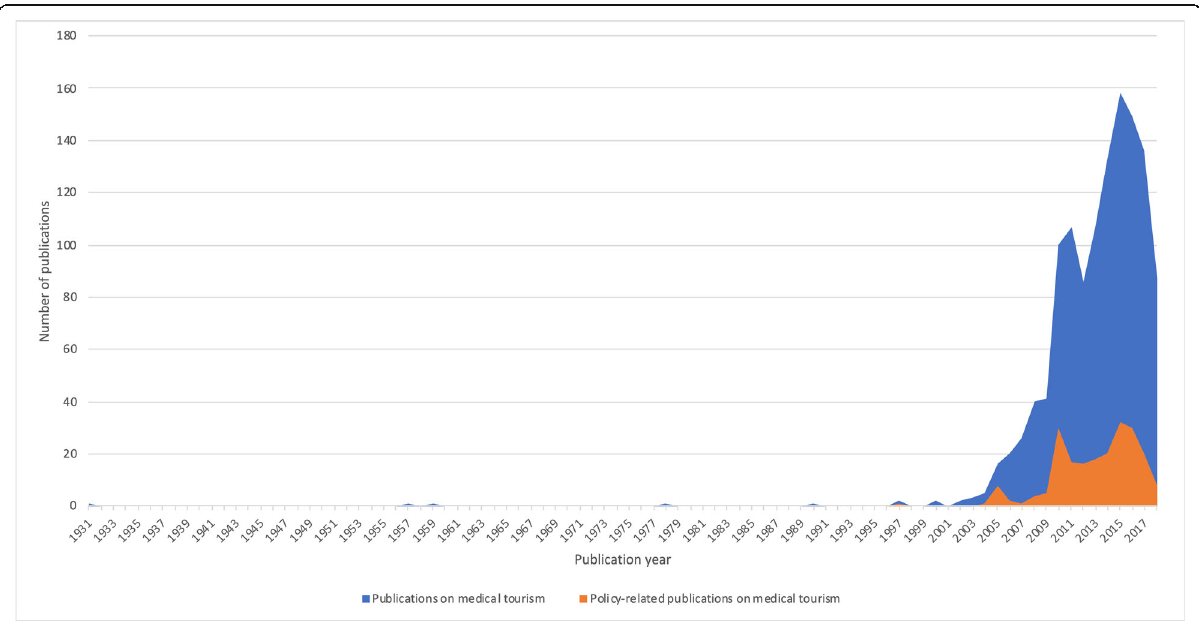
Fig. 3 Publication trends in medical tourism and policy